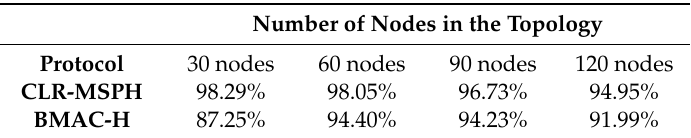
Figure 12. Scalability and percentage of handover data in each protocol. Table 5. Scalability and Packets Reception Rate. Table 6. Scalability and handover packets in each protocol.